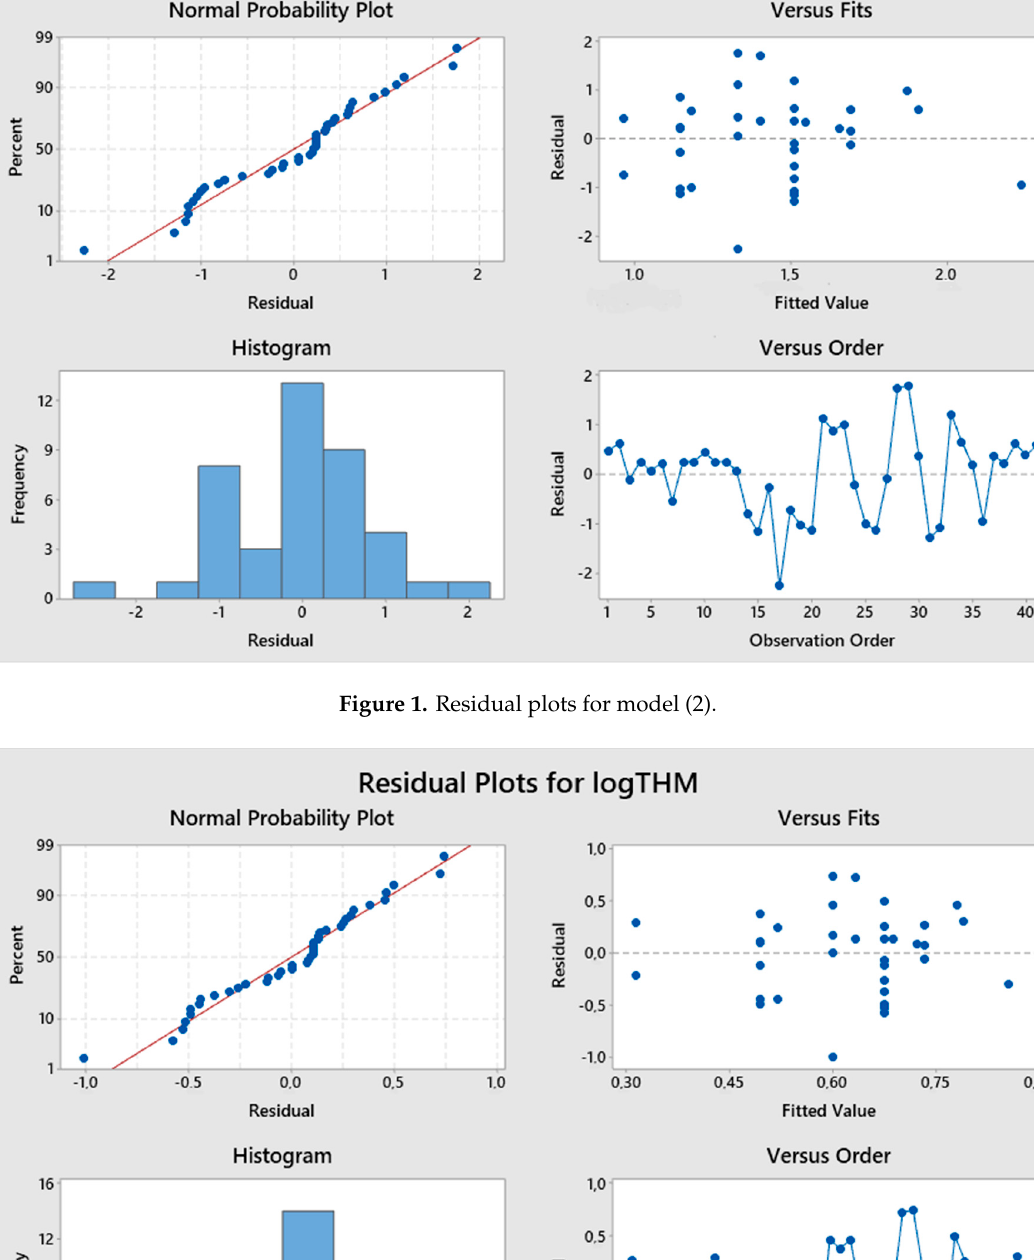
Figure 3. Residual plots for model (4).